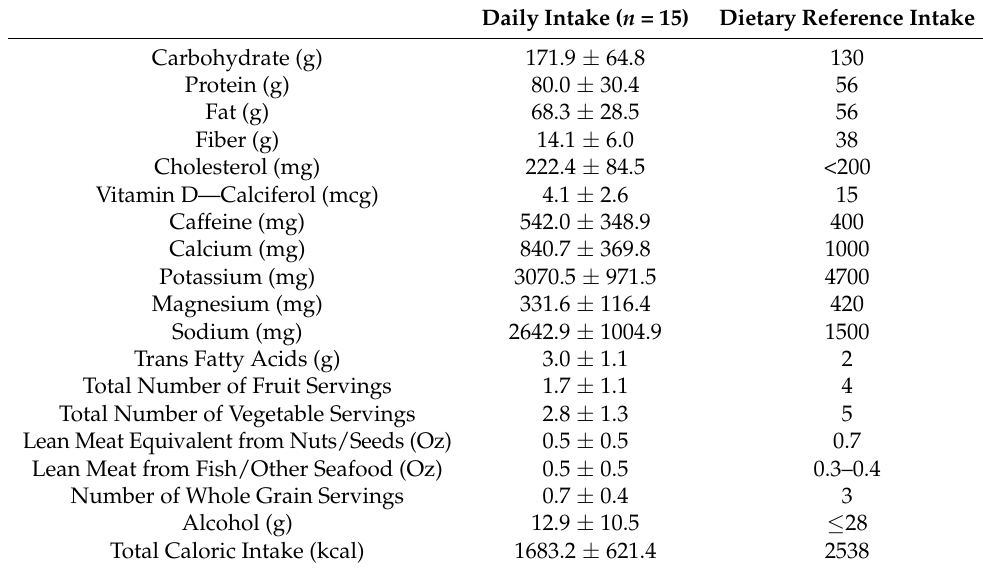
Table 2. Daily Average Nutrient Intake (mean ± SD) Compared to the Dietary Reference Intake.